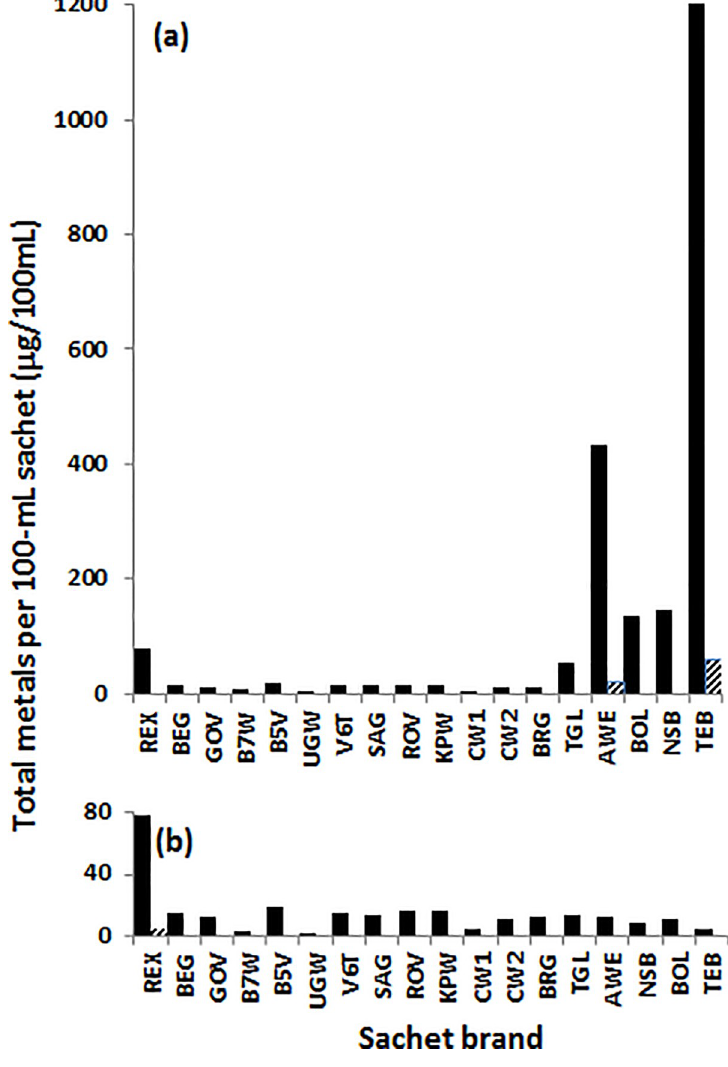
Fig 1. Sum of all metals detected in each sachet is shown as solid rectangles. (a) Cu is detected at high levels in locally distilled alcoholic drinks (AWE, 421 μ g/100 mL (97%); BOL, 123 μ g/100 mL (92%); NSB, 140 μ g/100 mL (94%); TEB, 1210 μ g/100 mL (100%) and in the Single Malt Scotch Whisky (TGL, 41 μ g/100 mL (76%)); the former due to long copper tubes employed in the distillation process, and the latter is due to copper pots used in the brewing and distillation processes. (b) An expansion of the plot in (a) without Cu, an outlier, to confirm the disproportionate level of copper in the Lira-Lira spirits. Note that levels of all metals are overrepresented in REX. Means are very low and shown as angle